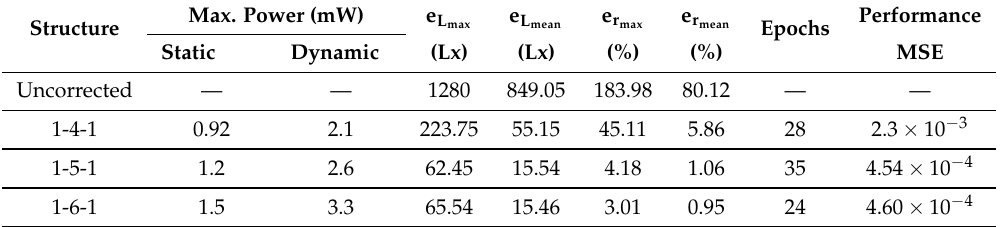
Table 4. Comparative summary of the three ANN structures for the non-linear characteristic NL3 . Structure